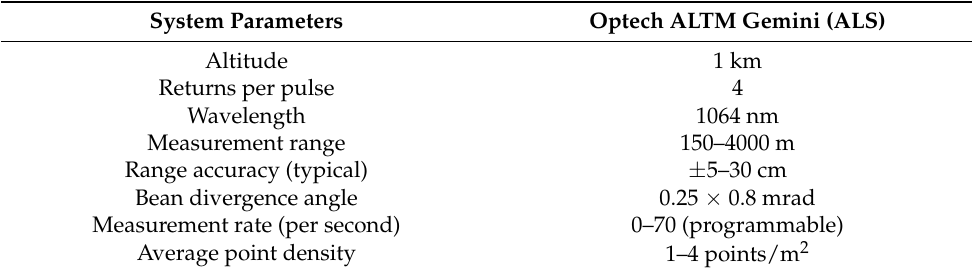
Table A1. NEON LiDAR system for aerial laser scanning (ALS)